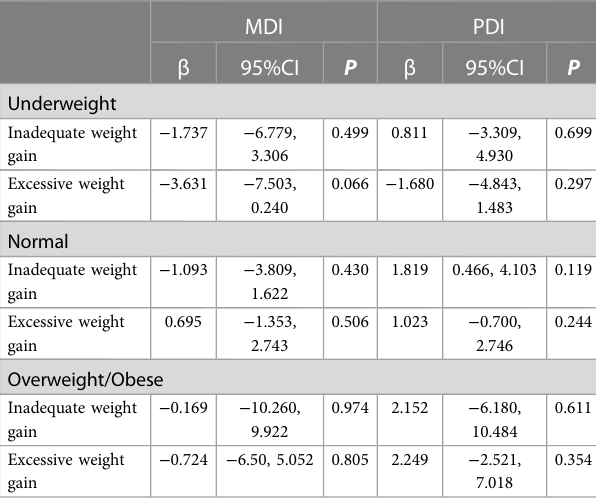
TABLE 4 Compares infant mental neurodevelopment at age 2 in accordance with the various IOM GWG categories according to wHO pre-pregnancy BMI classi fi